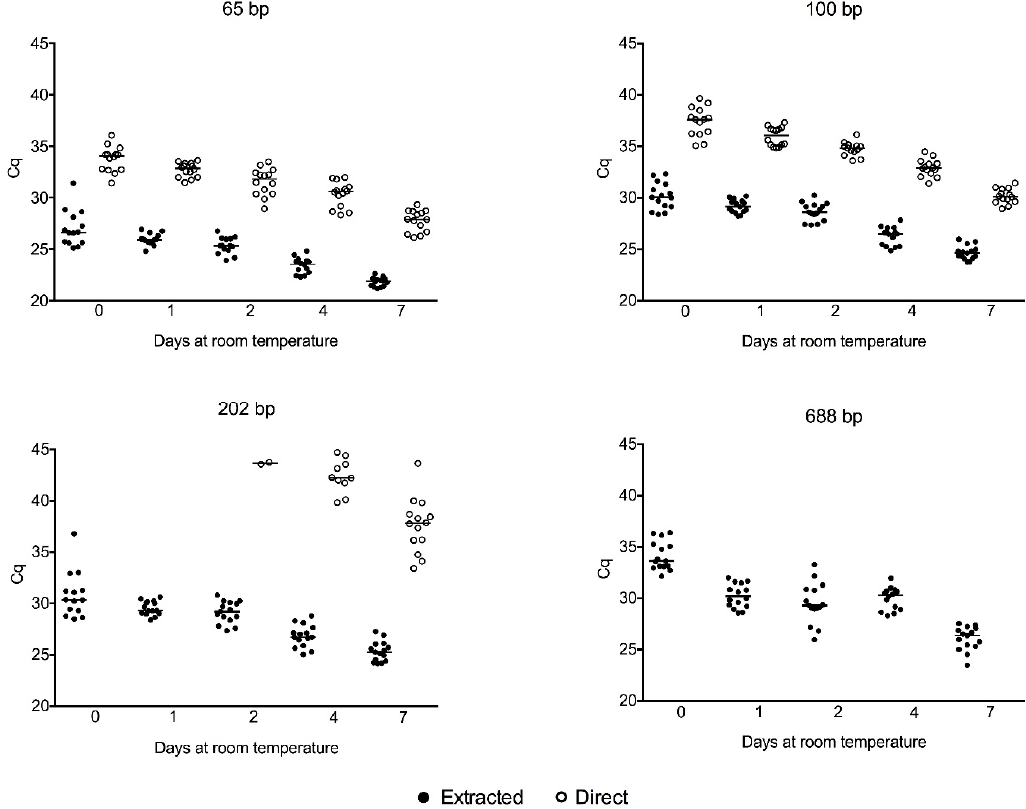
Figure 1. Quantitation cycle (Cq) values for amplicons of different sizes using DNA extracted from serum (closed circles) and crude serum directly (open circles) as template for qPCR. The line represents the median value.